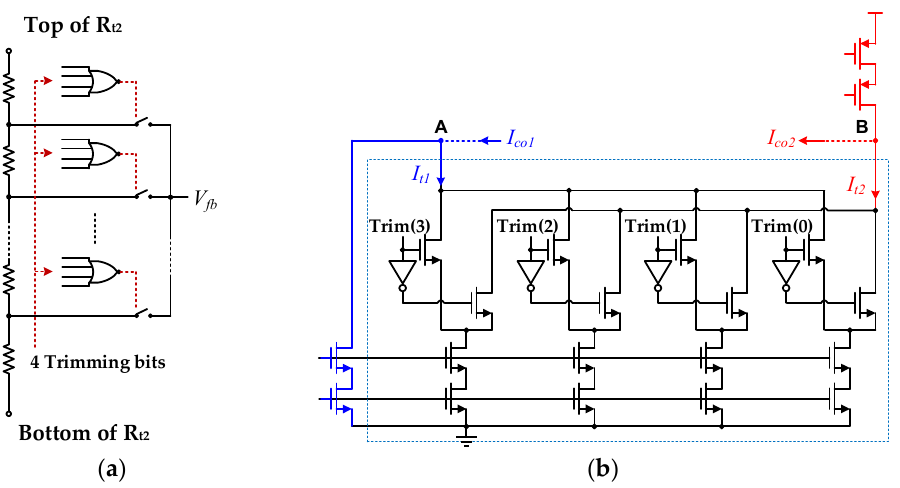
Figure 7. Schematic of the proposed trimming structure in BGR circuit: ( a ) resistance R t2 Trimming; ( b ) compensation current trimming.